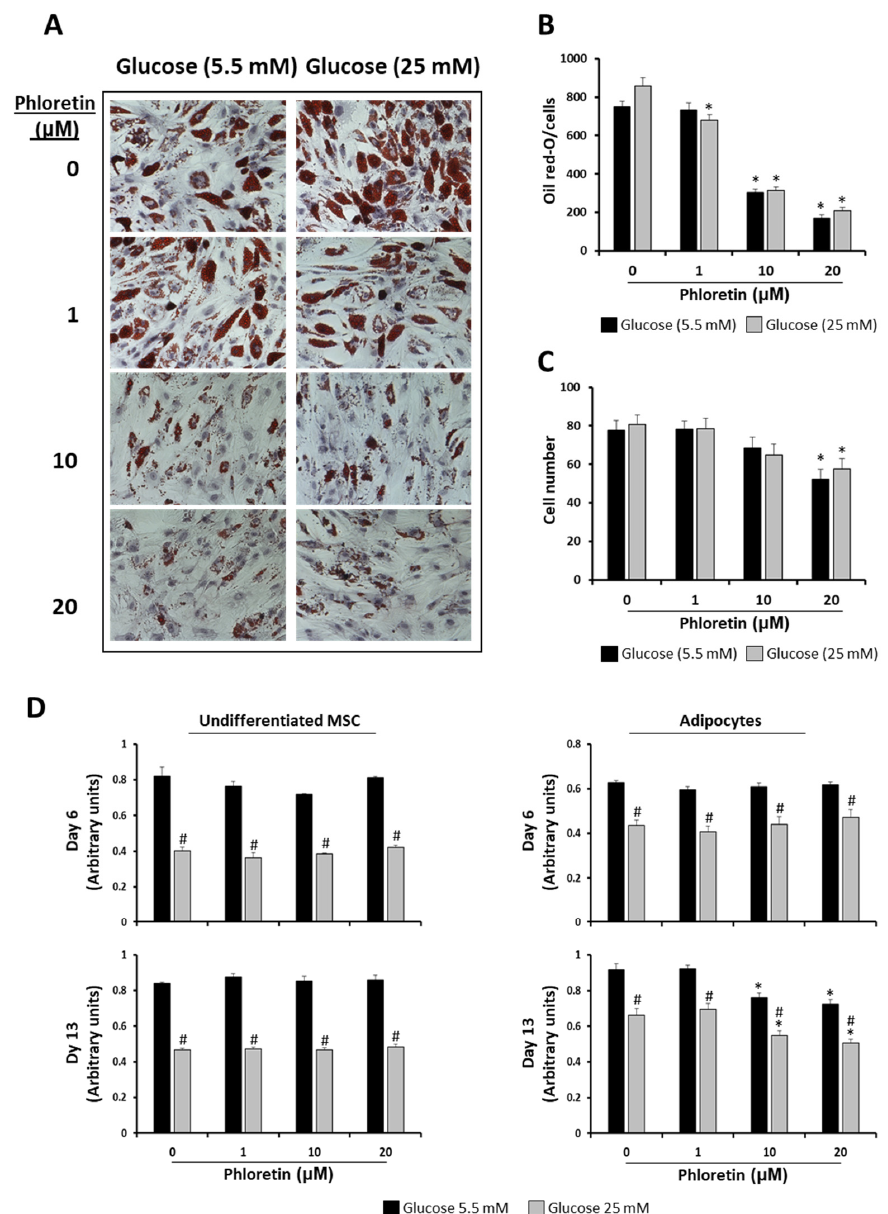
Figure 3. Phloretin decreases lipid accumulation and viability of MSC differentiated into adipocytes. ( A ) Representative light-microscopy pictures (200X) of oil red-O staining of lipid droplets, at day 13 of adipocyte differentiation, in presence of different concentrations of phloretin and glucose. ( B ) Results of quantification of oil red-O by image analyses. ( C ) Cell-number estimation in cultures by image analyses. ( D ) Viability at days 6 and 13 of undifferentiated and differentiating MSC into adipocytes, treated with different phloretin concentrations in medium containing 5.5 or 25 mM of glucose. * p < 0.05 vs. cultures not treated (0 µM of phloretin). # p < 0.05 vs. cultures in 5.5 mM of glucose treated with the same phloretin concentration.